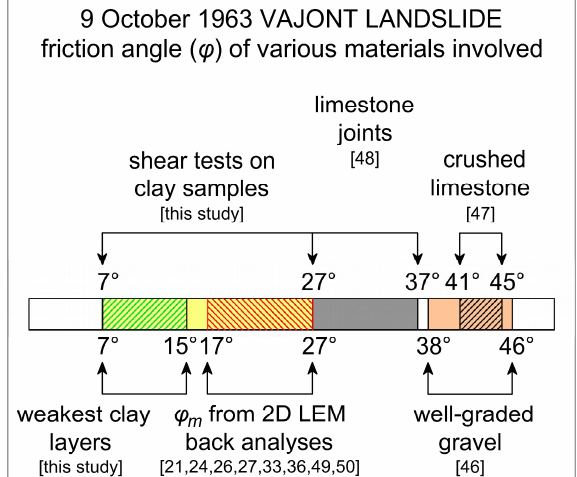
Figure 12. Typical ranges of the friction angle values of the different materials involved in the catastrophic collapse of the 1963 Vajont landslide.